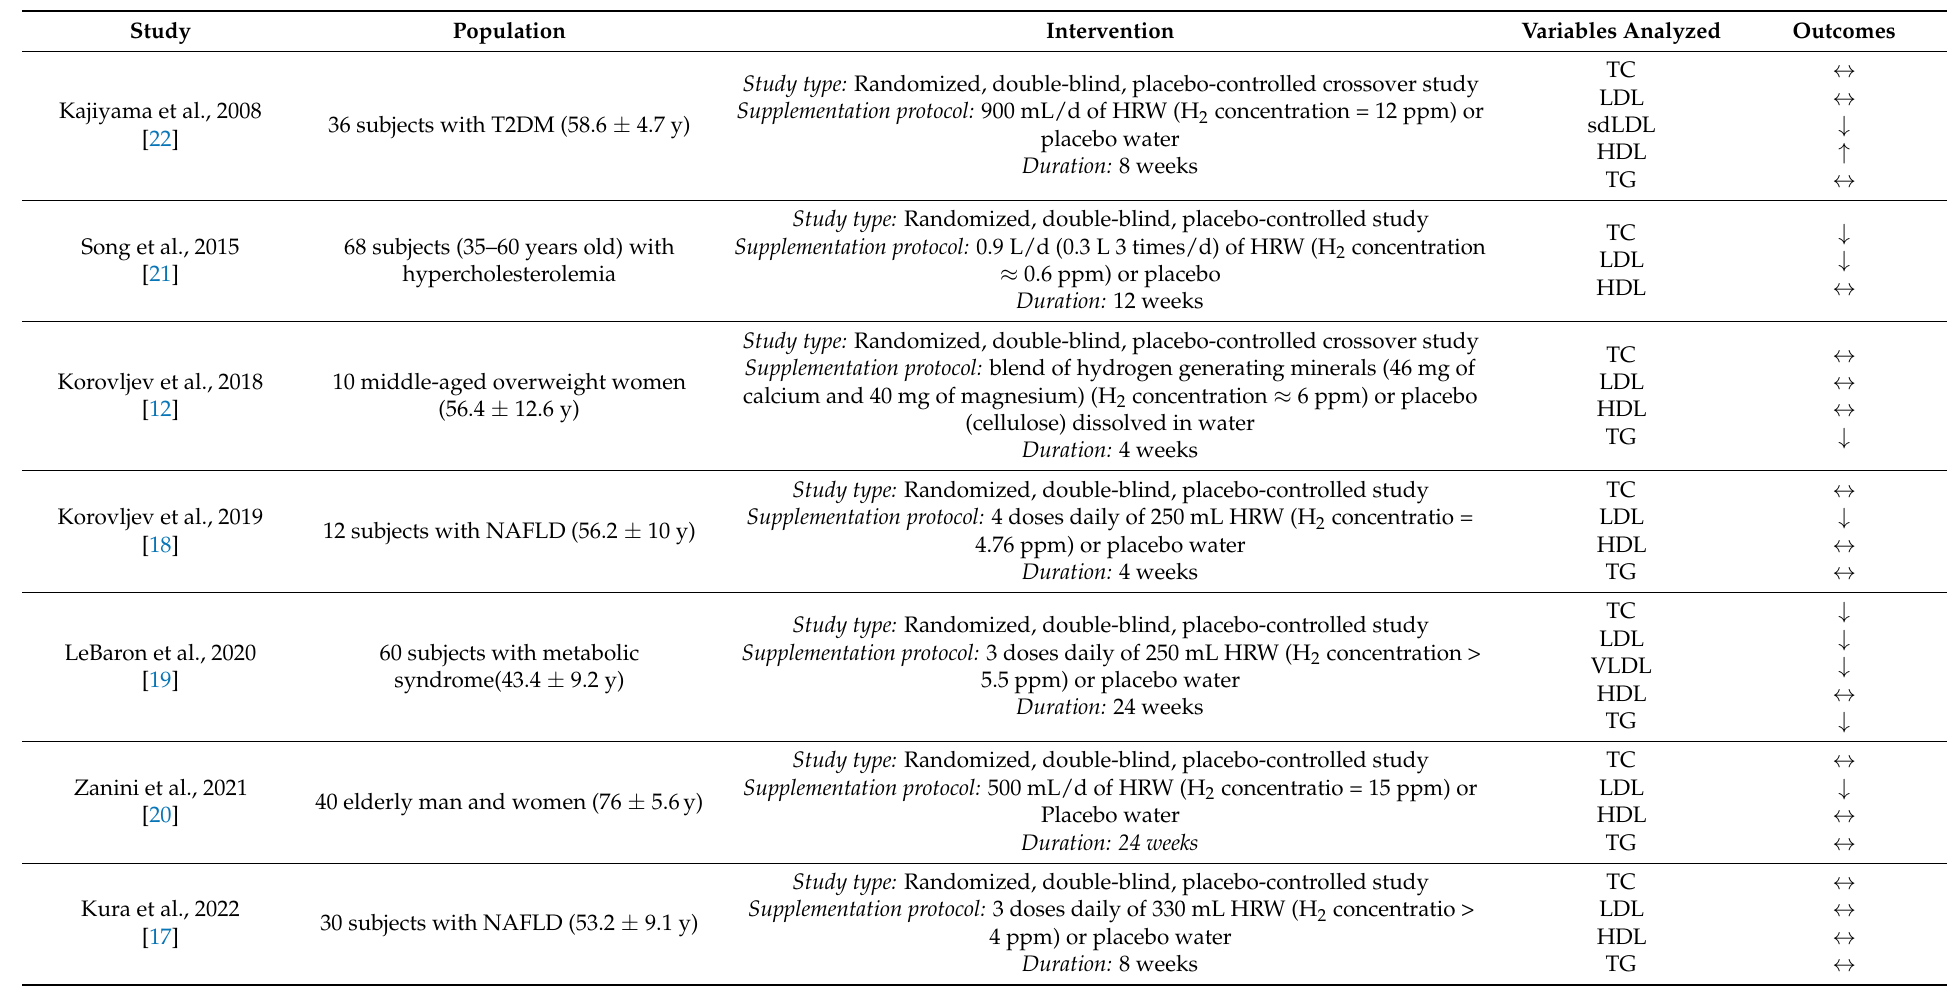
Table 1. Effects of molecular hydrogen on lipid